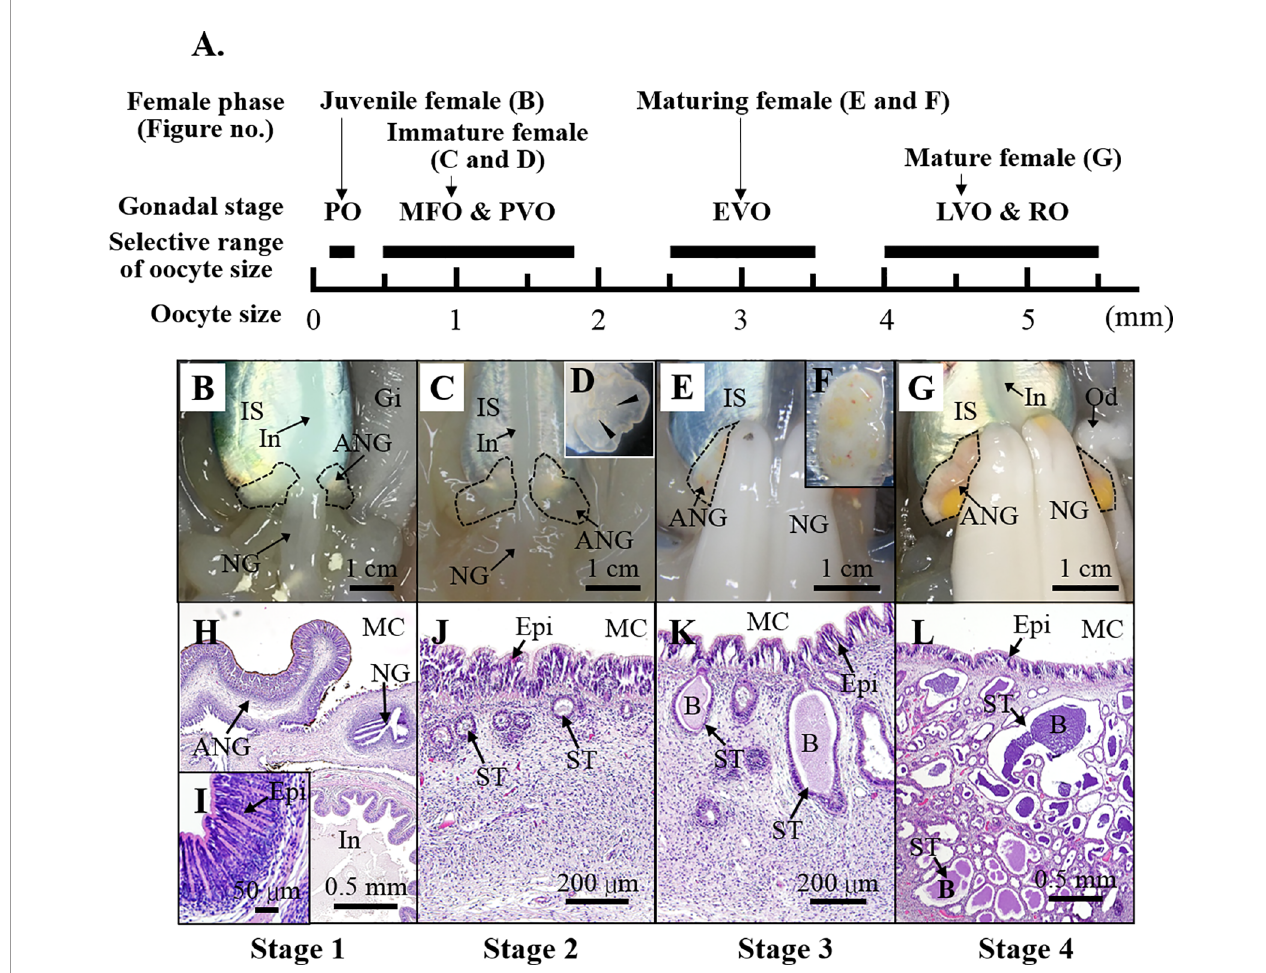
FIGURE 1 | The characteristics of ANG during female squid maturation. (A) The pro fi les of female growth, including the juvenile female (primary oocyte stage), immature female (multiple follicular oocyte stage and previtellogenic oocyte stage), maturing female (early vitellogenic oocyte stage), and mature female (late vitellogenic oocyte stage and ripe oocytes). (B – G) Morphological changes during ANG growth. (B) juvenile squid with a colorless ANG (stage 1); (C, D) immature squid with a colorless ANG several white spots (stage 2); (E, F) maturing squid with a white/light-orange ANG (stage 3); (G) mature squid with a pigmented ANG (stage 4). (H – L) Histological changes during ANG growth. (H, I) juvenile squid with a colorless ANG without visible bacterial fl ora (stage 1); (J) immature squid with a colorless ANG with bacterial fl ora (stage 2); (K) maturing squid with a white/light-orange ANG with large numbers of bacterial fl ora (stage 3); (L) mature squid with a pigmented ANG with large numbers of bacterial fl ora (stage 4). PO, primary oocyte; MFO, multiple follicular oocyte; PVO, previtellogenic oocyte; EVO, early vitellogenic oocyte; LVO, late vitellogenic oocyte stage; RO, ripe oocyte; IS, ink sac; In, intestine; Gi, gill; NG, nidamental gland; ANG, accessory nidamental gland; Od, oviduct; MC, mantle cavity; Epi, epithelial cell; ST, secondary tubule; B,